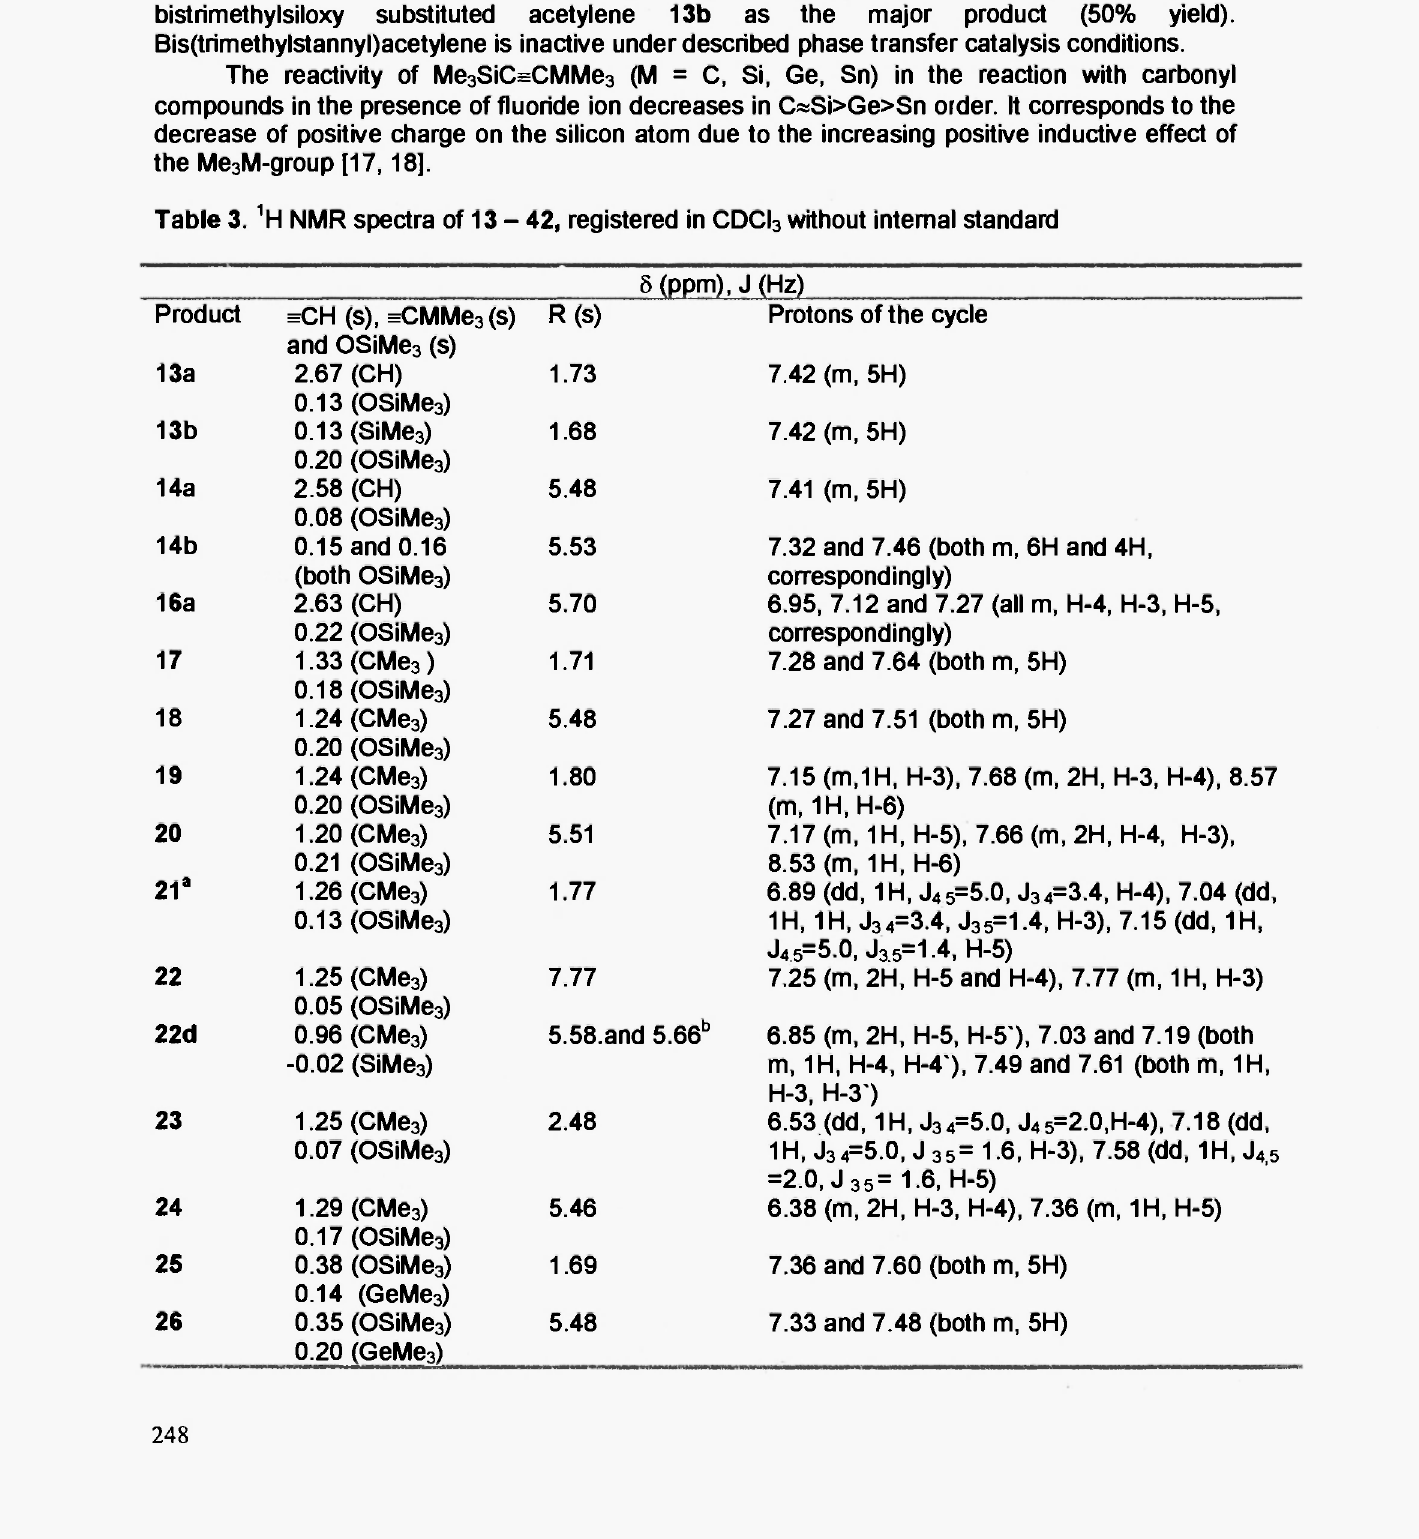
without internal 3